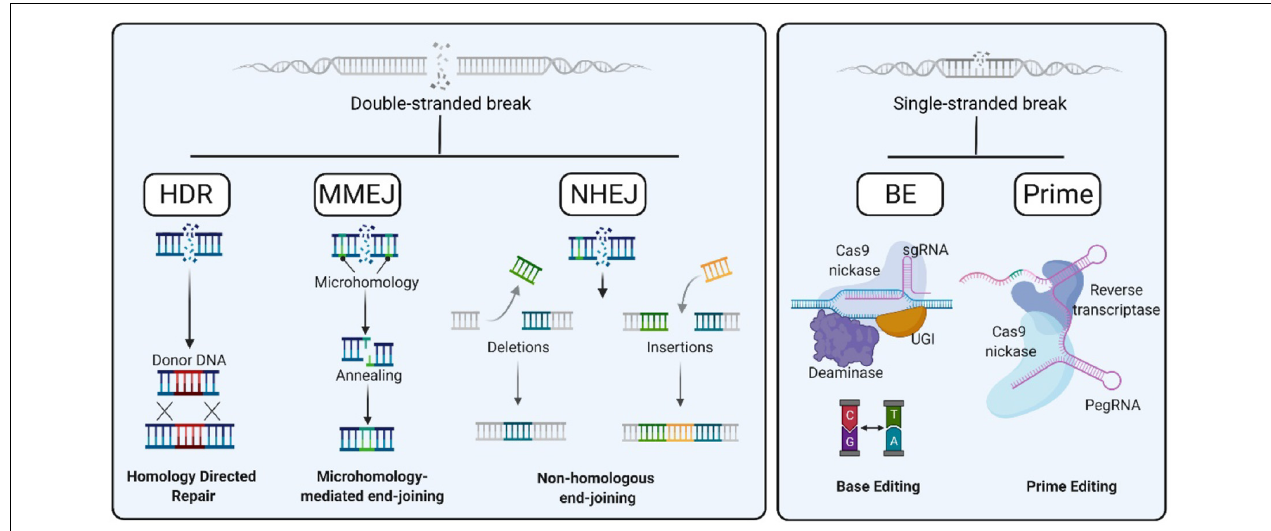
FIGURE 3 | Gene editing strategies. After a Double Strand Break (DSBs) event, the preferential cellular pathways for its repair are homology directed repair (HDR), microhomology mediated end joining (MMEJ), and non-homologous end-joining (NHEJ) (left) . DNA can also be repaired in a DSB-independent manner, by means of Base Editing and Prime Editing (right)